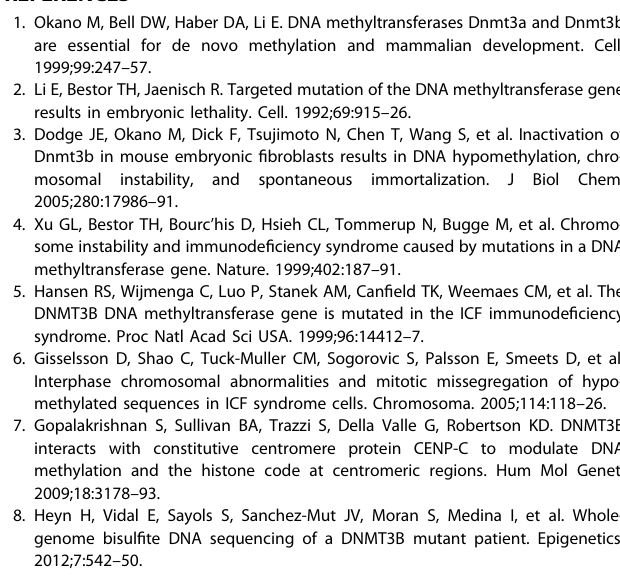
Fig. 7 PARP1-mediated EJ repair in ICF cells. a ICF cells were fi xed for γ H2AX/ACA, Rad51/ACA, and 53BP1/ACA IF co-staining. Representative confocal co-localized signals (scale bar, 10 μ m). Manders ’ coef fi cient of co-localized γ H2AX/ACA, Rad51/ACA, and 53BP1/ACA was acquired by confocal imaging as described in the methods. Examples of co-localized signals of γ H2AX/ACA and 53BP1/ACA are shown under the Merged image. Co-localized signals are quantitated ( n > 100) and expressed in relative values of Manders ’ coef fi cient, *** P < 0.001 by